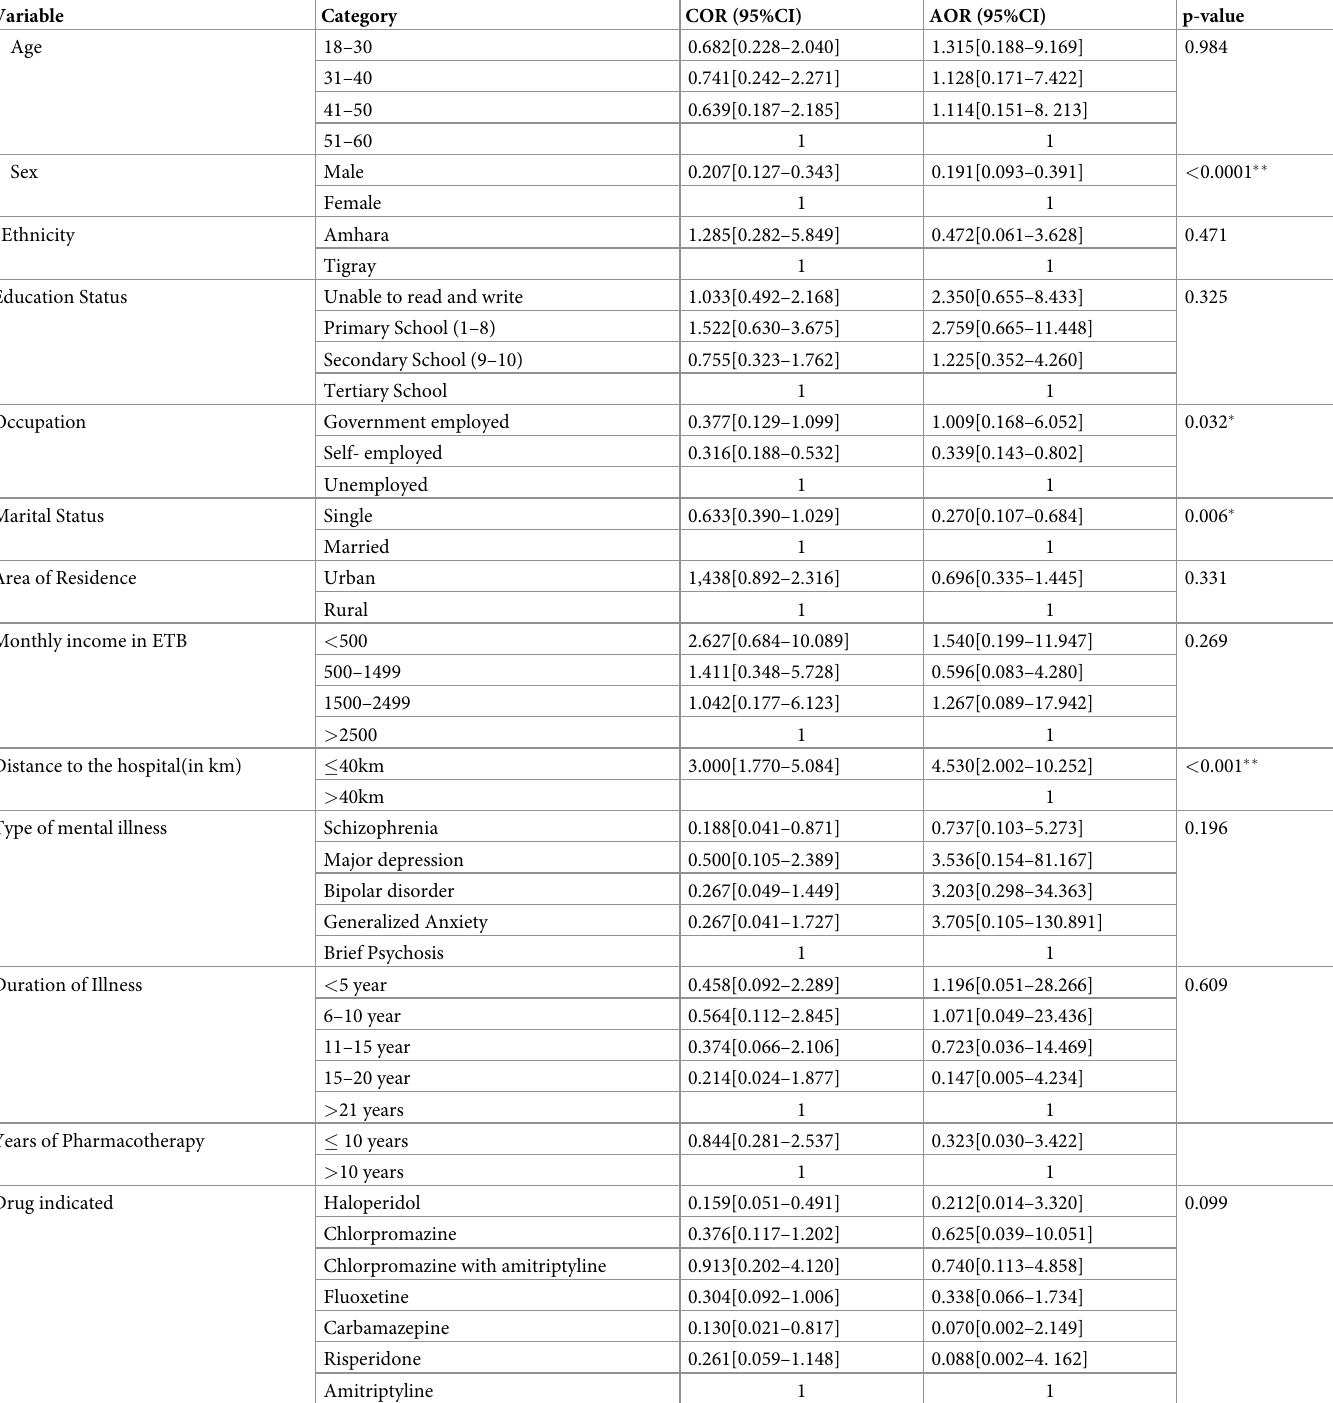
Table 2. Univariable and multivariable binary logistic regression analysis of predictors of metabolic syndrome